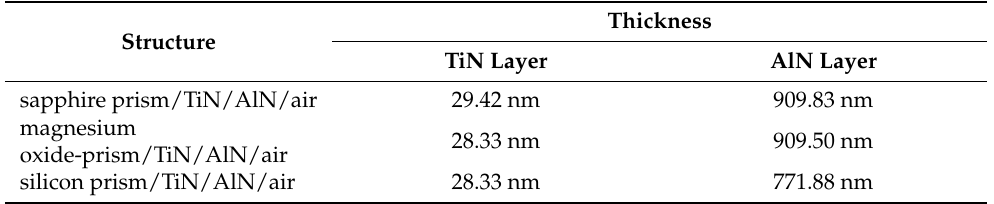
Table 2. The optimum of the TiN and AlN layer thicknesses of three CPWR sensors, predicted by GA